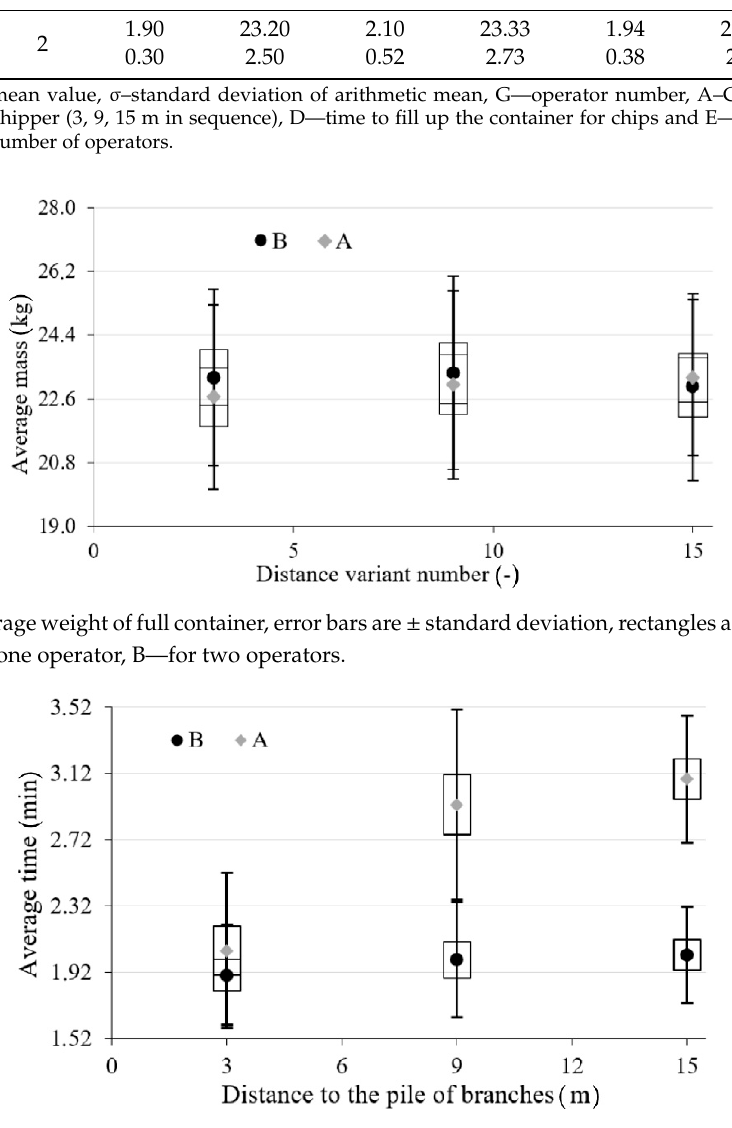
Figure 10. Mass productivity of the chipping process; A—for one operator, B—for two operators, C— increase ratio of mass productivity when the number of operators was increased to two.